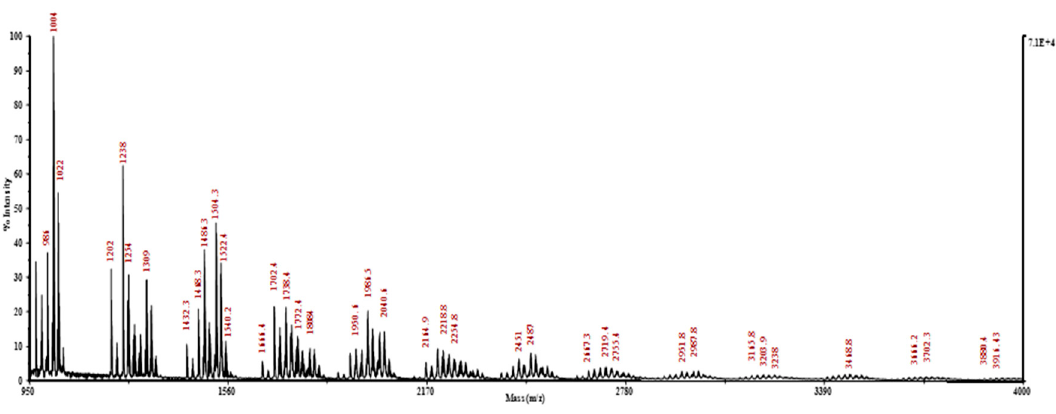
Figure 4. MALDI-TOF mass spectrum of the P(ESES-co-ESDPA) 50:50 copolymer. Polymers 2020 , 12 , x FOR PEER REVIEW